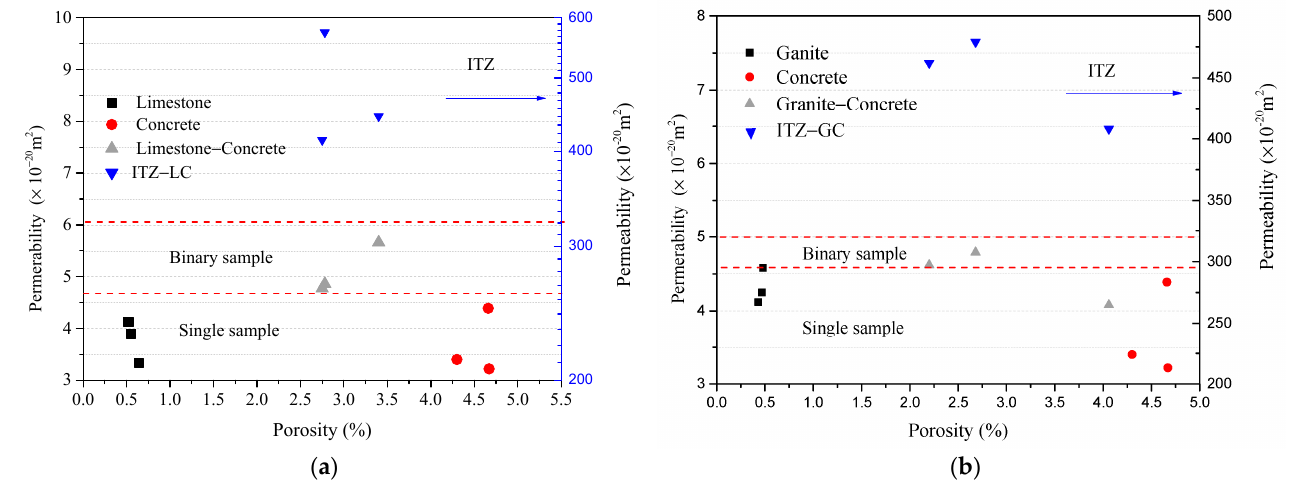
Figure 12. Comparison of permeability test results of different types of rock, concrete and binary specimens, ( a ) limestone, ( b ) granite.